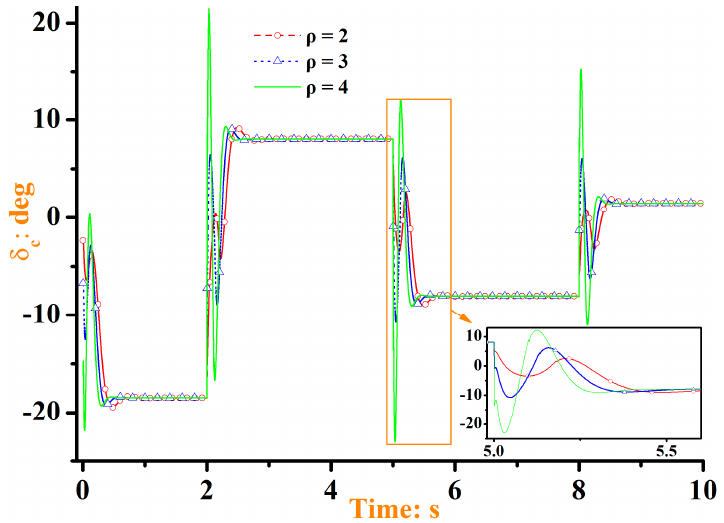
Figure 9. Validation with different control order ρ : Tail deflection δ c